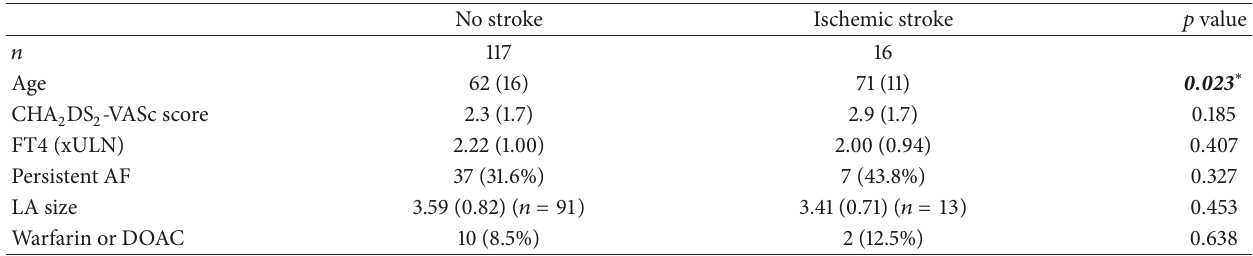
Table 4: Comparison of clinical characteristics in patients who did not have a stroke and patients who had sustained an ischemic stroke. No